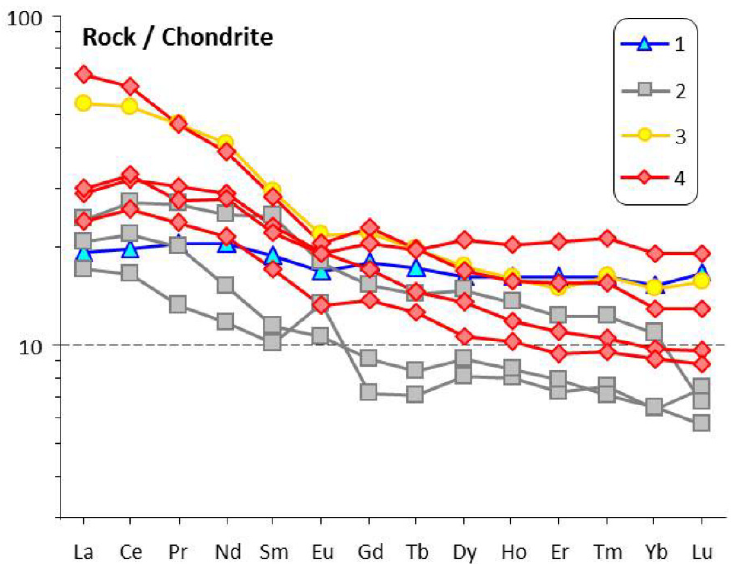
Figure 9. Chondrite-normalized REE spectra for pyroxenite and beerbachite. Color legend is the same as in Figure 8. Chondrite composition is after [29].